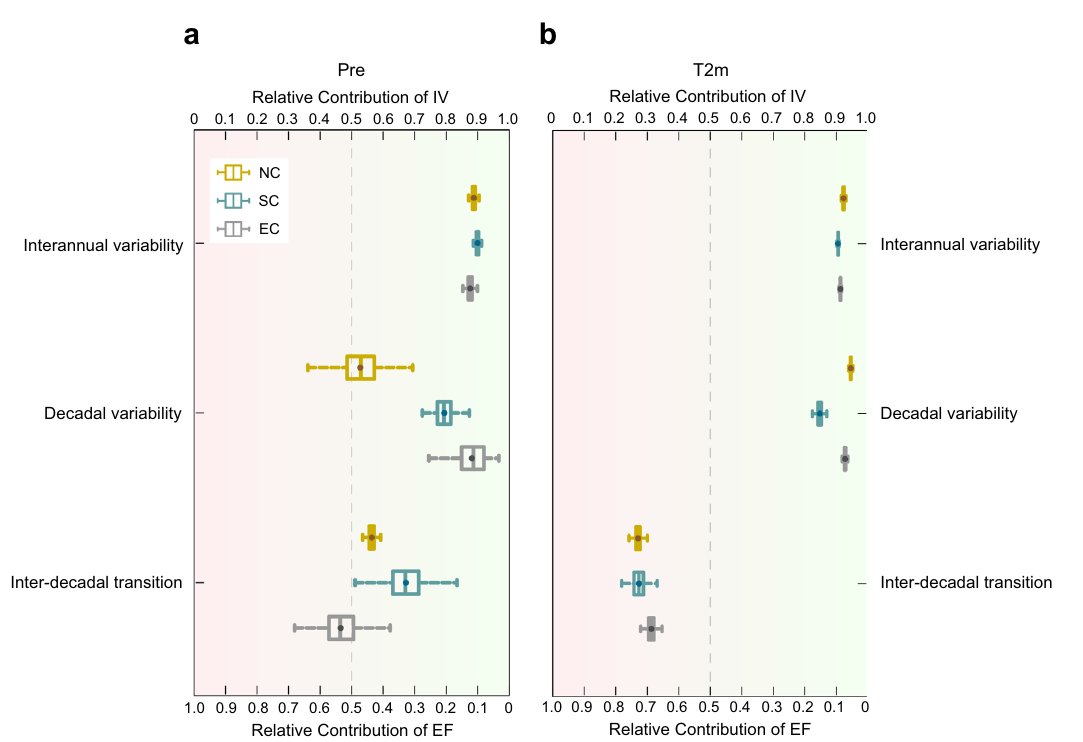
Fig. 4 Relative weight analysis of the annual mean precipitation and temperature. Relative weight analysis was applied to quantify the contributions of internal variability (IV) and external forcing (EF) to various timescales of the annual mean precipitation/temperature at 2 m over the grids in North China (NC: 35 – 43°N, 110 – 122°E; gold), South China (SC: 24 – 32°N, 110 – 122°E; green) and eastern China (EC: 22 – 43°N, 110 – 122°E; gray), respectively. Different combinations of intrinsic mode functions (IMFs) from EEMD represent the interannual variability (IMF1 + 2), decadal variability (IMF3 + 4) and nonlinear trend (IMF5), respectively. The nonlinear trend corresponds to the inter-decadal transition of a the annual precipitation pattern or b the warming trend. Bootstrap sampling with replacement was performed 1000 times on the spatial fi elds of the combinations of IMFs to estimate the uncertainty range of the relative weights of IV and EF. Box-plot elements: center line, median; dots, mean; box limits, upper (75th) and lower (25th) percentiles; whiskers, 1.5 times the interquartile